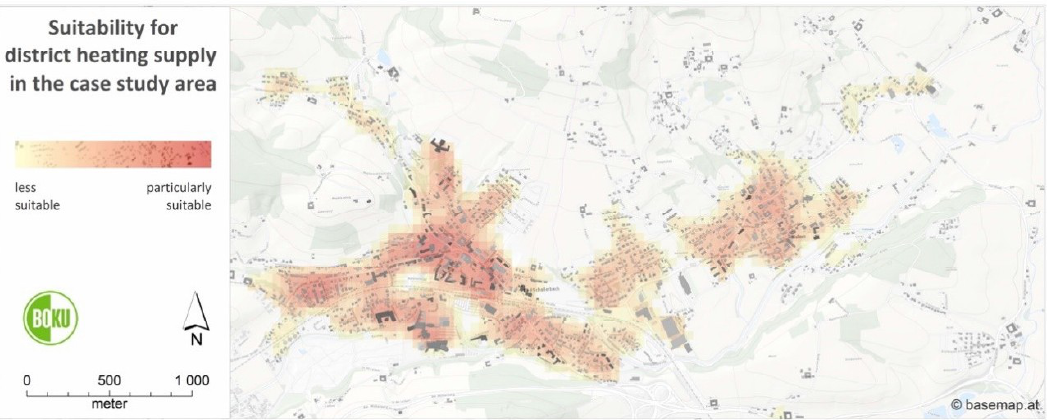
Figure 6. Visualisation of the suitability for district heating supply in both case study municipalities (own